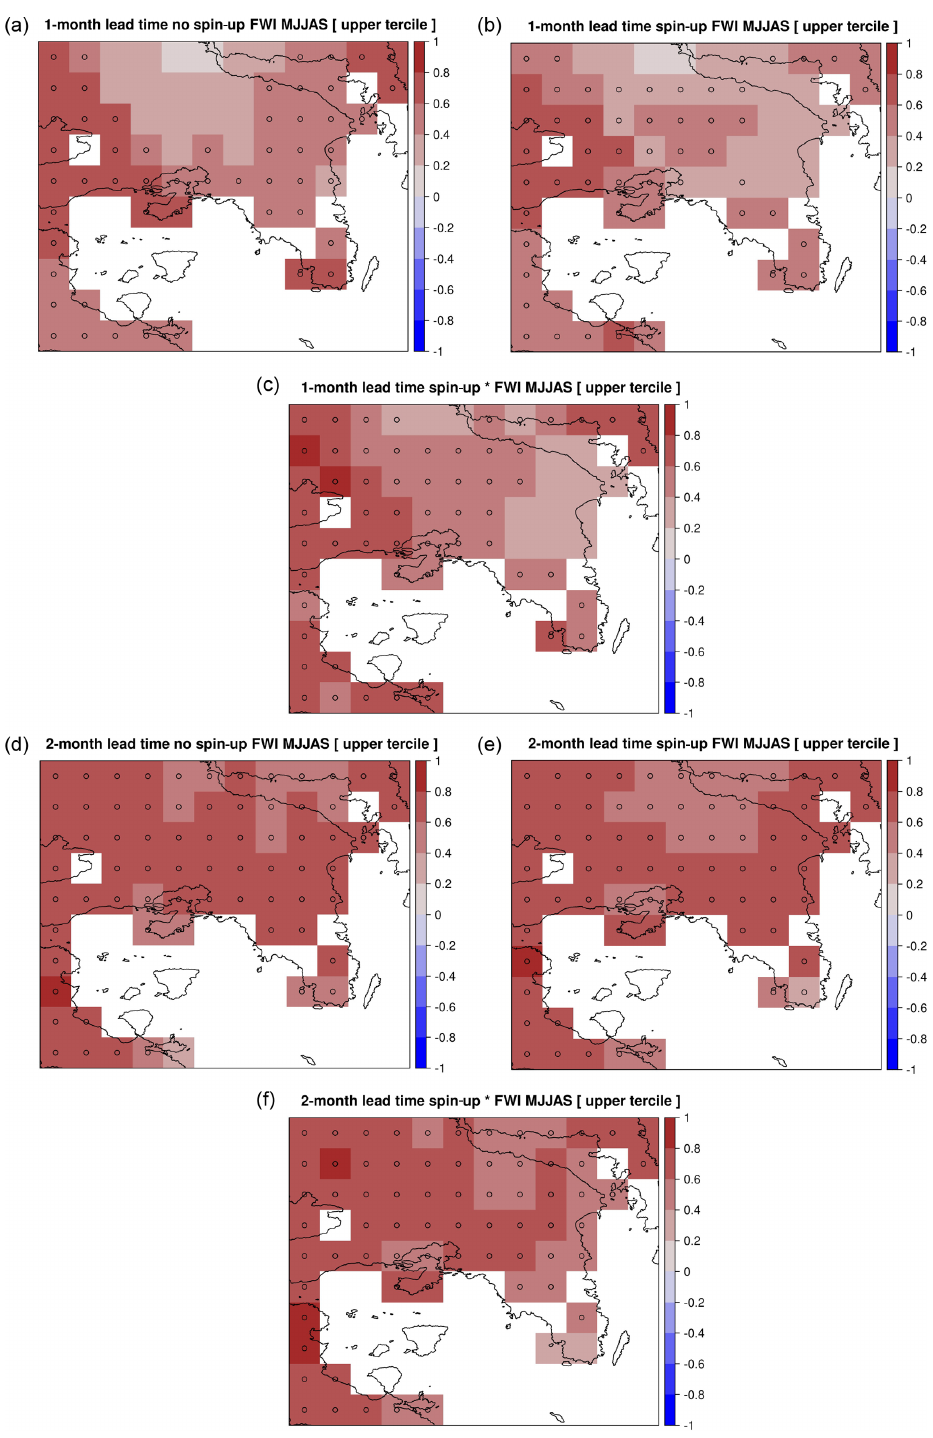
Figure 2. ROC skill scores (ROCSSs) of the upper-tercile SEAS5 FWI predictions for a 1-month lead time – (a) with no spin-up, (b) with spin-up using the SEAS5 data and (c) with spin-up implanting the ERA5-Land data – and a 2-month lead time – (d) with no spin-up, (e) with spin-up using the SEAS5 data and (f) with spin-up implanting the ERA5-Land data. The grid points with significant ROCSS values are indicated by circles ( α = 0 .